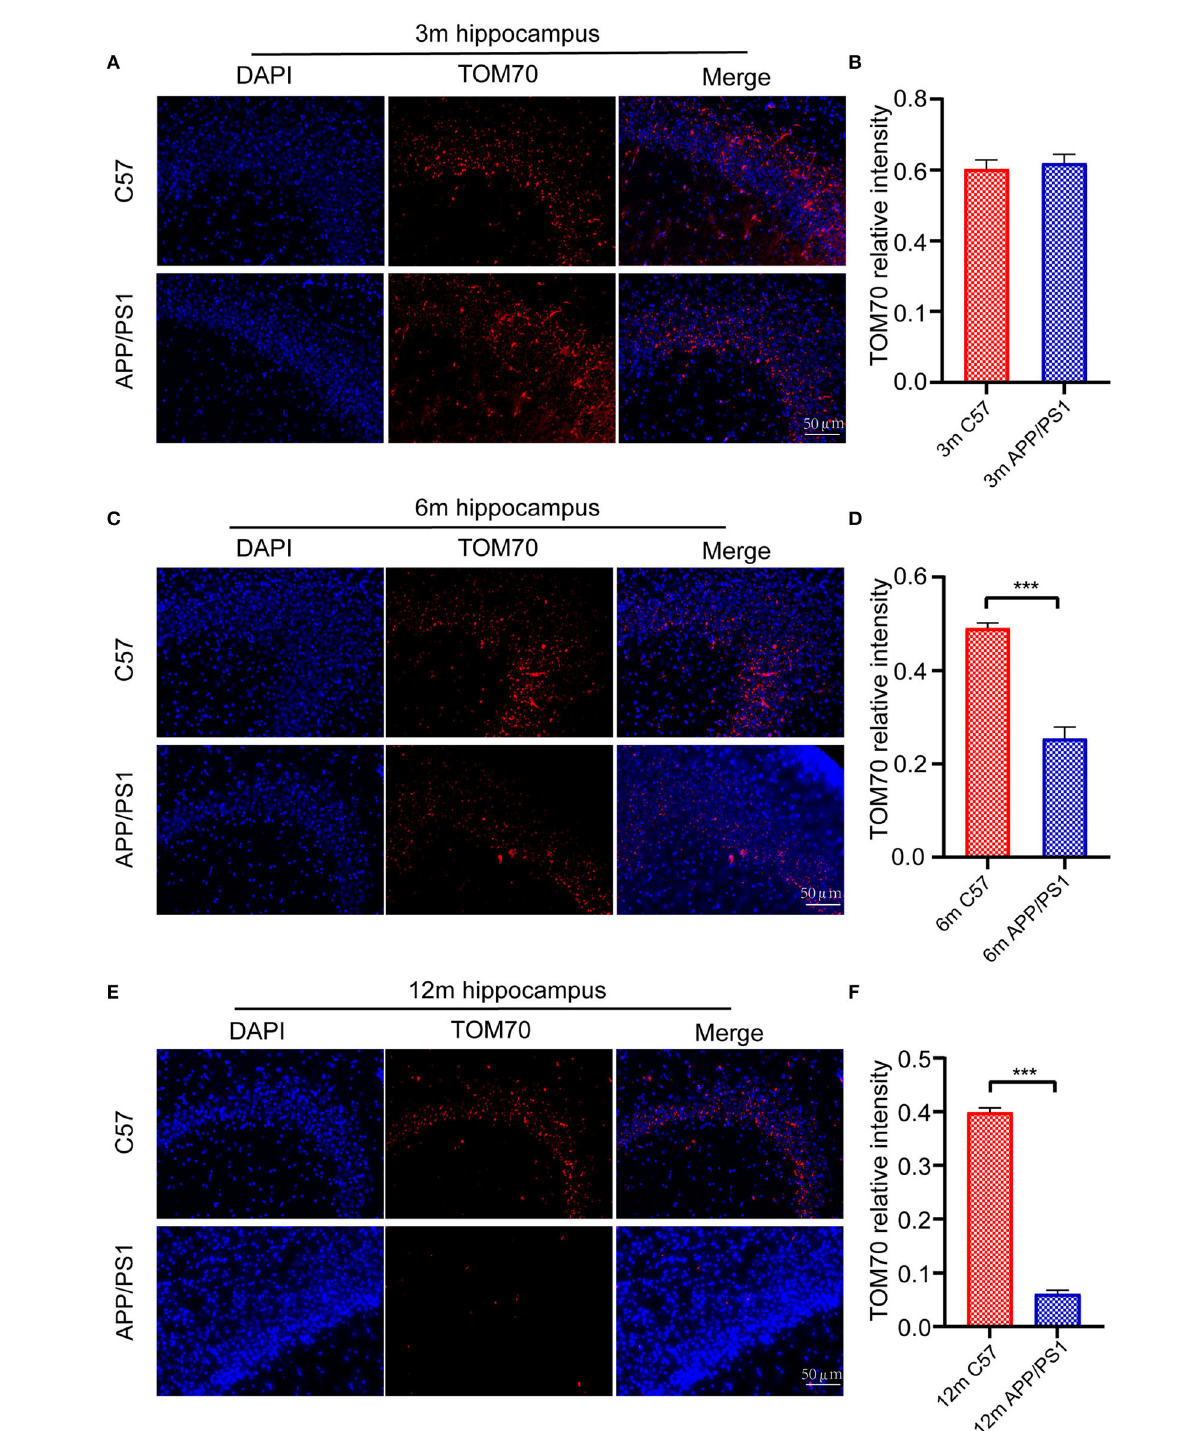
FIGURE5 Immunofluorescence assay for mouse hippocampus. Fluorescence intensity of TOM70 was significantly decreased in the hippocampus of APP/PS1 mice at 6 and 12 months. (A) DAPI and TOM70 fluorescence for the hippocampus of 3-month C57 and APP/PS1 mice. (B) TOM70 fluorescence relative intensity in the hippocampus of APP/PS1 mice at 3 months. (C) DAPI and TOM70 fluorescence for the hippocampus of 6-month C57 and APP/PS1 mice. (D) TOM70 fluorescence relative intensity in the hippocampus of APP/PS1 mice at 6 months. (E) DAPI and TOM70 fluorescence for the hippocampus of 12-month C57 and APP/PS1 mice. (F) TOM70 fluorescence relative intensity in the hippocampus of APP/PS1 mice at 12 months. Scale = 50 µ m. The data are mean ± SEM ( n = 3). *** P <